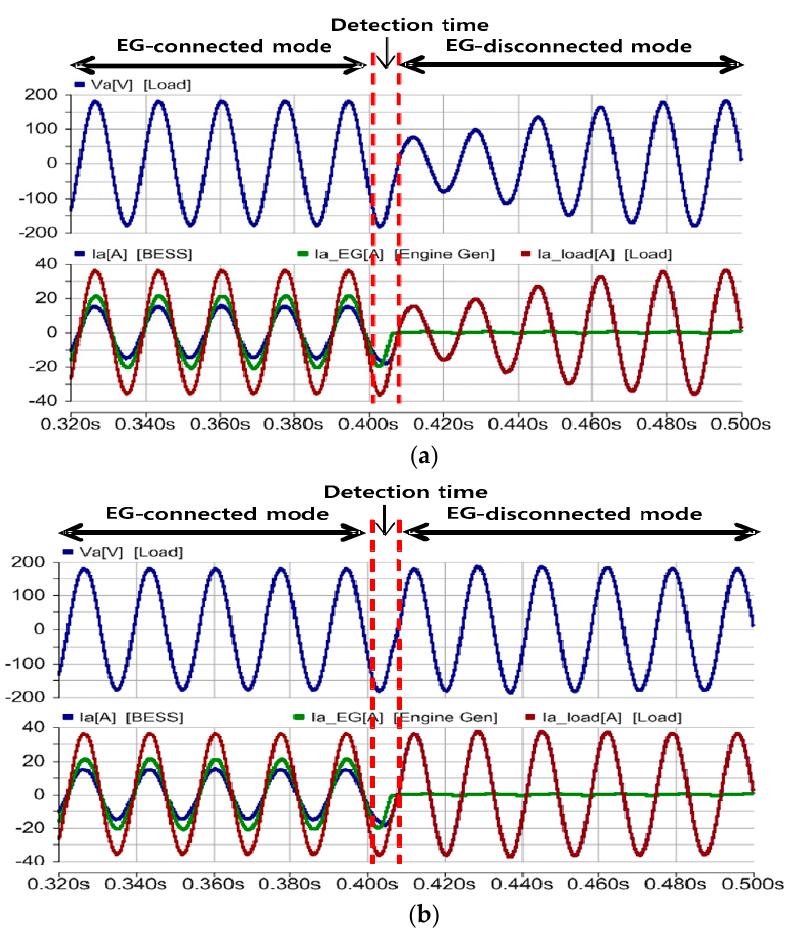
Figure 10. Mode change from current control to voltage control: ( a ) Without initial values; ( b ) With initial values. Fix mistakes in figure labels: EG ‐ connected.